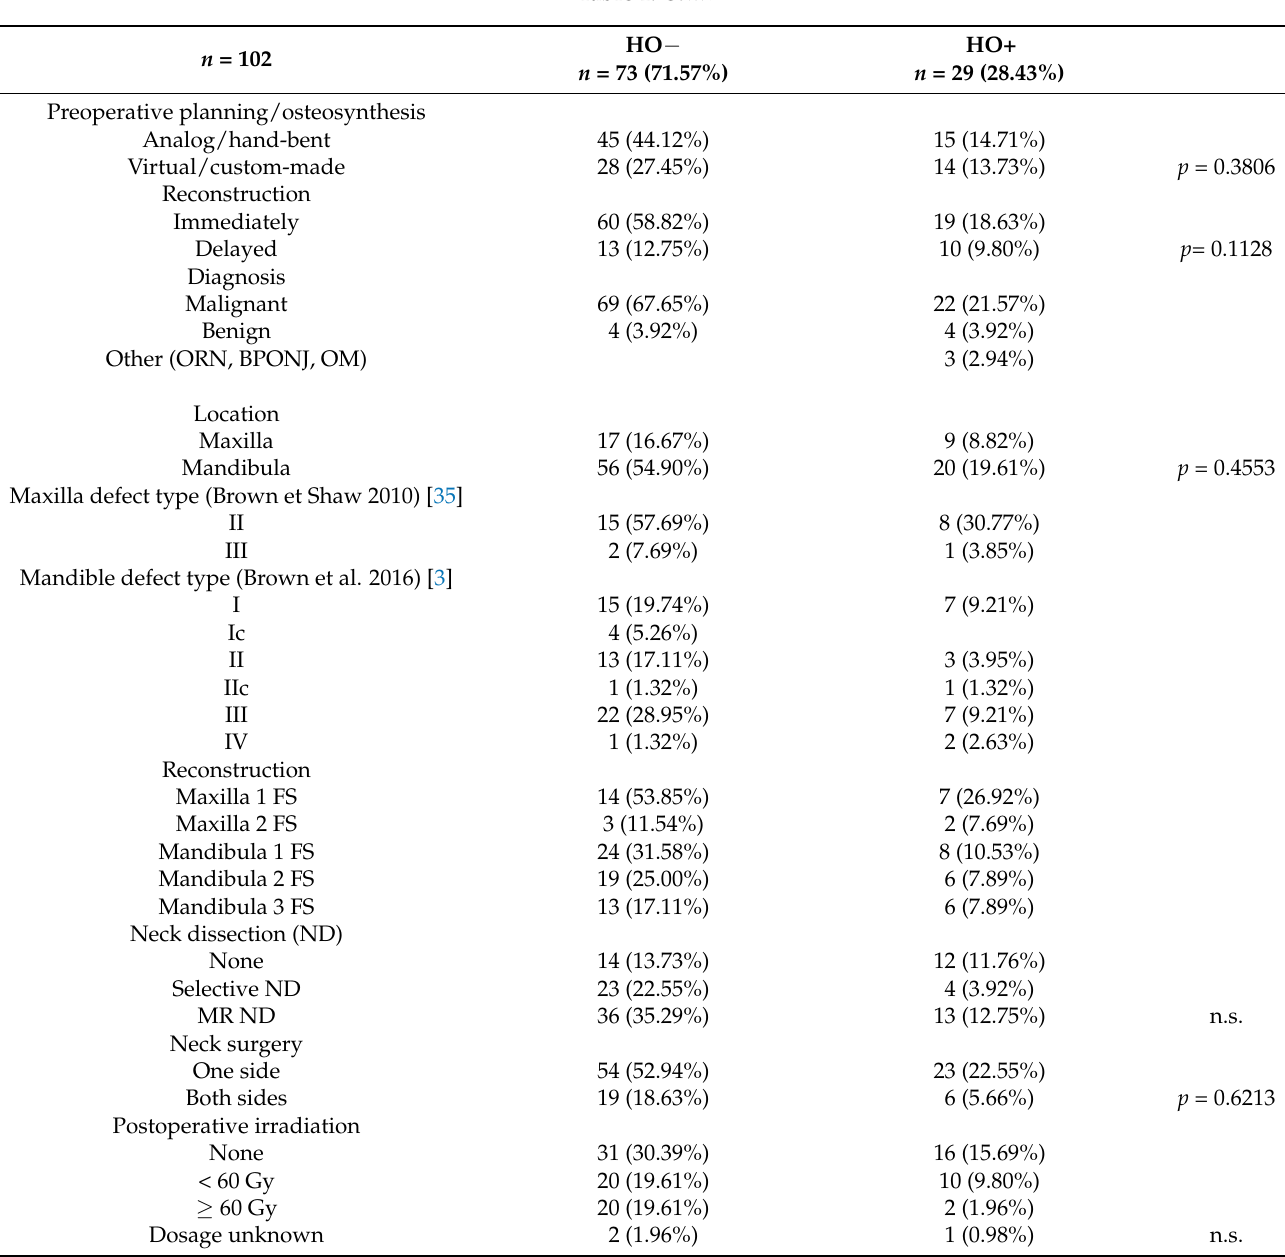
Table S1 in the supplementary material depicts the collected data of our 29 patients with radiological HO (M: n = 25 (86.2%), F: n = 4 (13.8%)). Extraosseous ossification occurred in 34.6% ( n = 9 out of 26) after maxillary and in 26.3% ( n = 20 out of 76) after mandibular reconstruction. The difference was not statistically significant ( p = 0.4553). The onset of HO in the CT-scan was drawn as incidence function (Kaplan Meier func- tion), cumulative for reconstruction of maxilla and mandible with FFF (Figure 3). After an average time of 13.48 months (median 9.0 months), HO was observed in CT scans. Compar- ing time of detection of HO after maxillary (median = 5 months, 95% CI = 4.0–20.0 months) and mandibular reconstruction, it is noticeable that maxillary HO occurred six months earlier than mandibular HO (median = 9.5 months, 95% CI = 5.0–13.0 months) (Figure